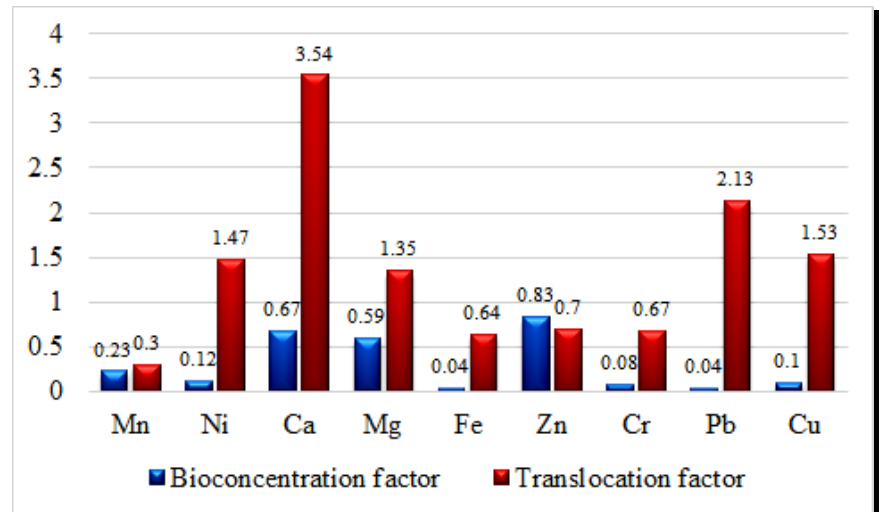
Figure 1. Bioconcentration factor (blue) and translocation factor (red) for Rumex acetosella . Total contents phenol of the